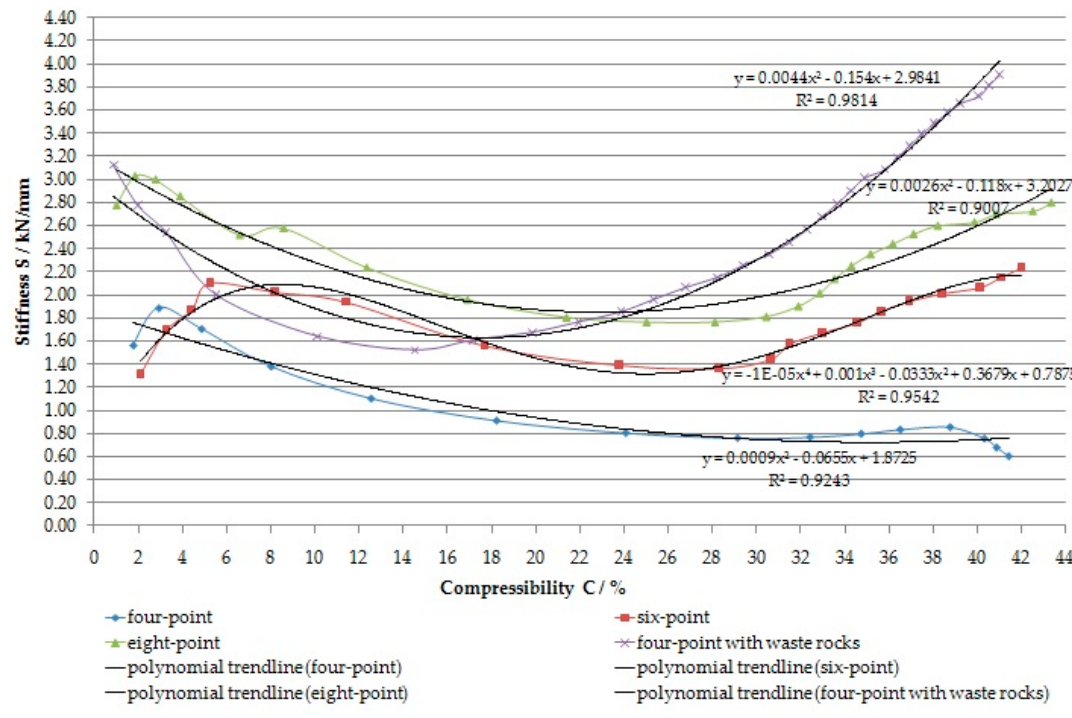
Figure 14. The stiffness of the wooden cribs for increasing compressibility. Figure 14. The sti ff ness of the wooden cribs for increasing Table 3. Comparison of the stiffness of the wooden cribs for increasing compressibility.